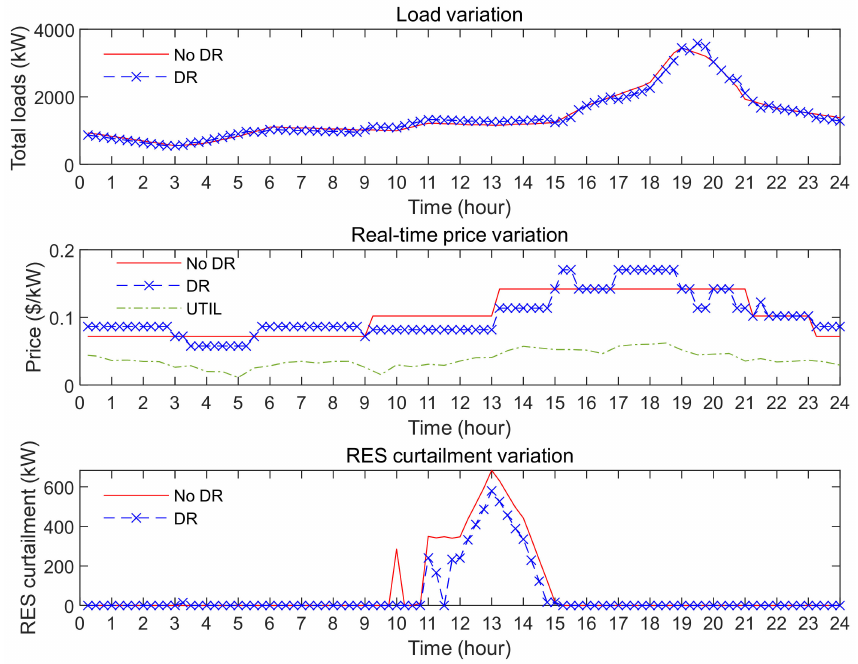
Figure 6. Variations of load demand, real-time prices, and RES curtailment for load type A (the distribution operator cannot sell electricity to the utility grid).